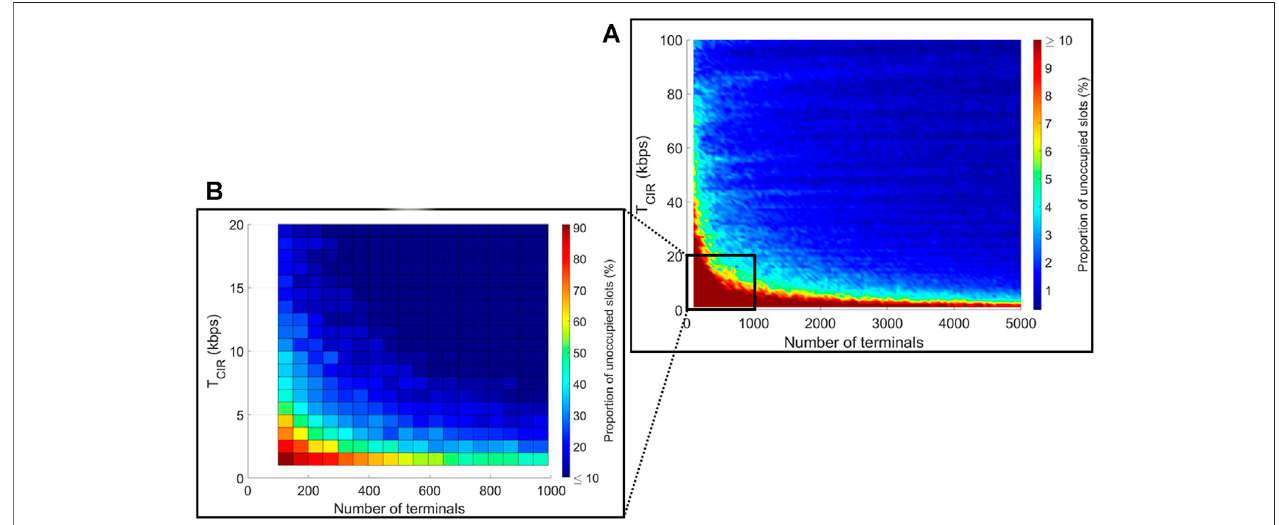
FIGURE 9 | Proportion of unoccupied slots in the intuitive carrier plan in function of number of user terminals and T CIR .